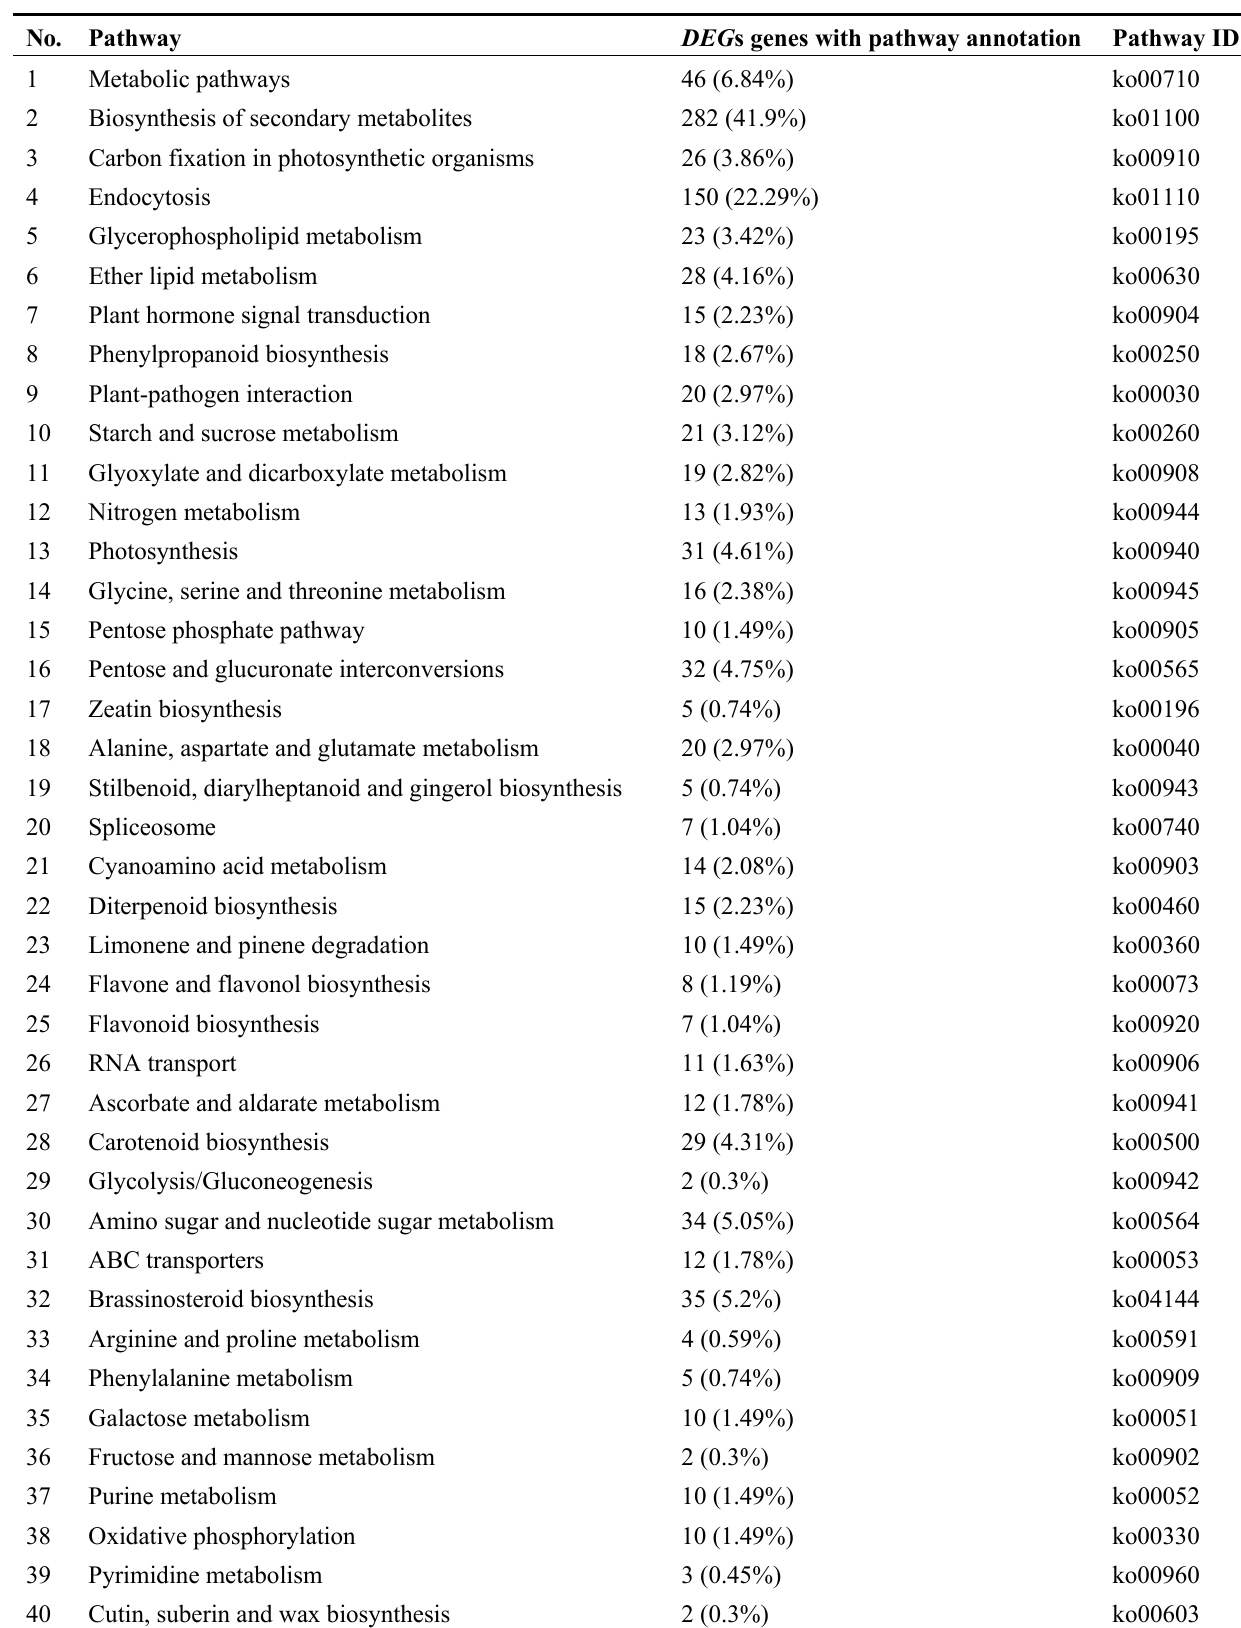
Table 3. Statistical analysis of the Kyoto Encyclopedia of Genes and Genomes (KEGG) analysis of the DEG s in both the PA2T vs. PA2 and PA4T vs. PA4 comparisons.